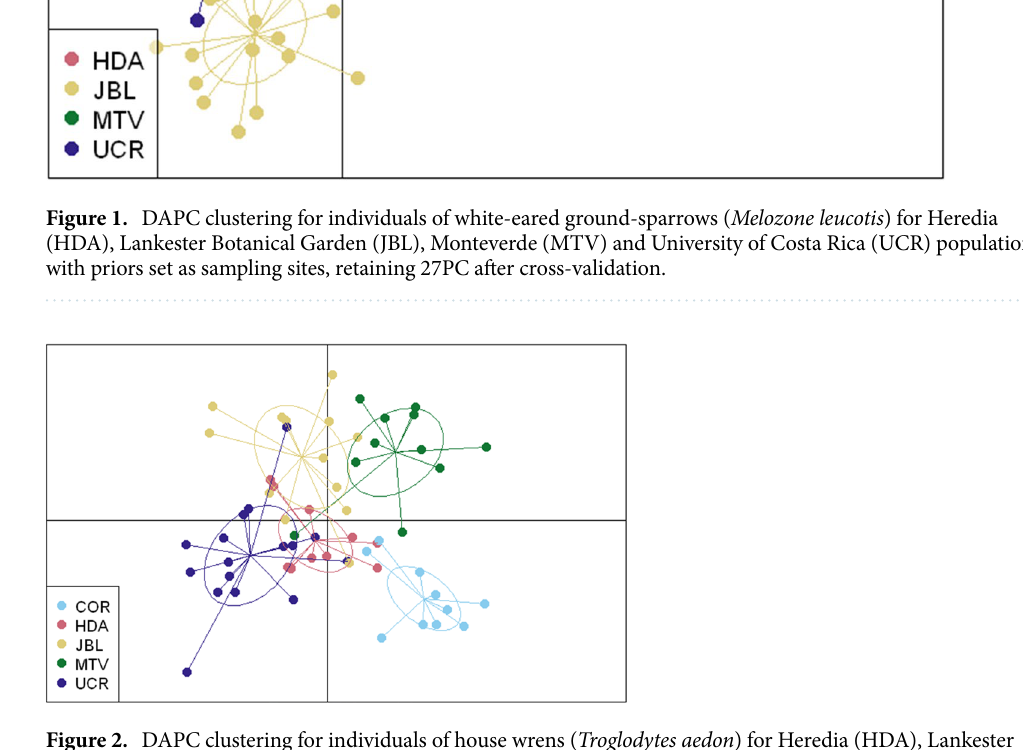
Figure 2. DAPC clustering for individuals of house wrens ( Troglodytes aedon ) for Heredia (HDA), Lankester Botanical Garden (JBL), Monteverde (MTV), University of Costa Rica (UCR) and Corredores (COR) populations with priors set as sampling sites, retaining 18PC after